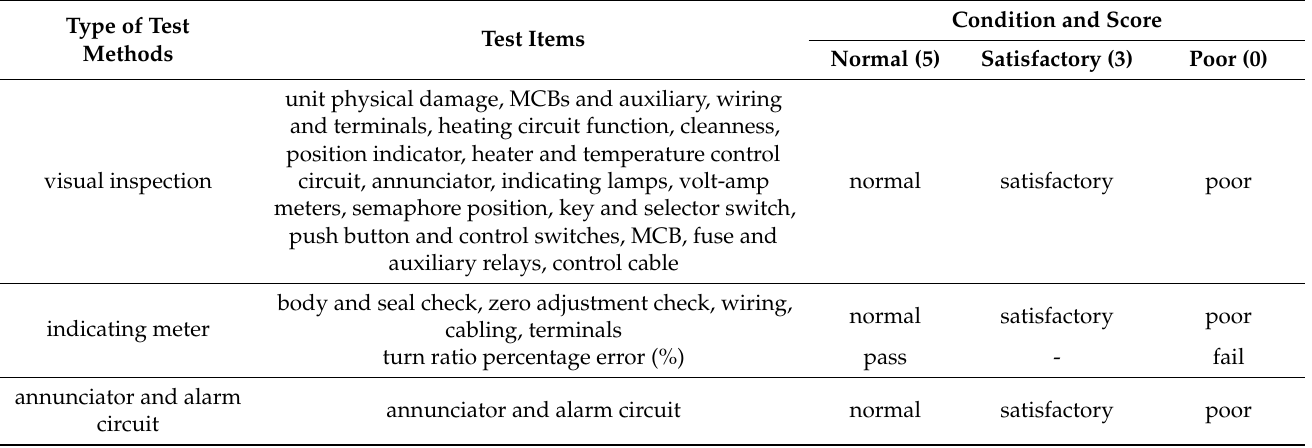
Table 2. LCC testing methods and visual